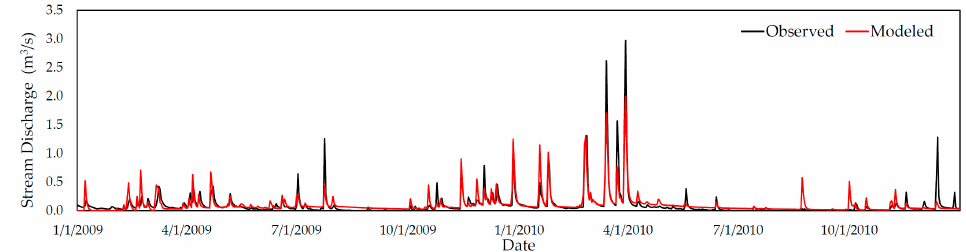
Figure 2. A simulated 2009–2010 hydrograph produced by the calibrated Cork Brook SWAT model compared to observed data from USGS Gauge 01115280.